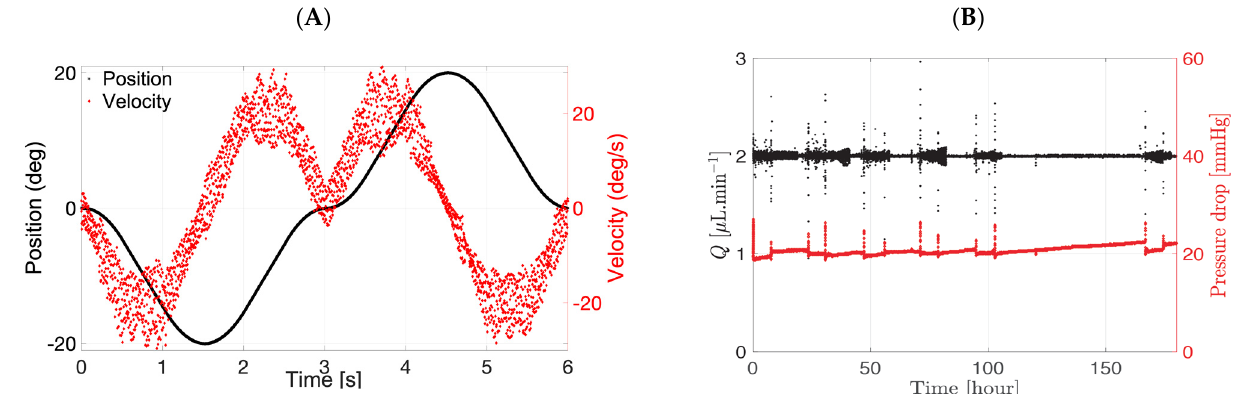
Figure 4. Slow pursuit movement with the ( A ) velocity and position and ( B ) pressure and flow rate of a PK-Eye™ model connected to the microfluidic and eye movement platform. The microfluidic system is able to maintain a steady flow rate of 2.0 µL/min while each PK-Eye™ model rotates back and forth by 20° on the eye movement platform.